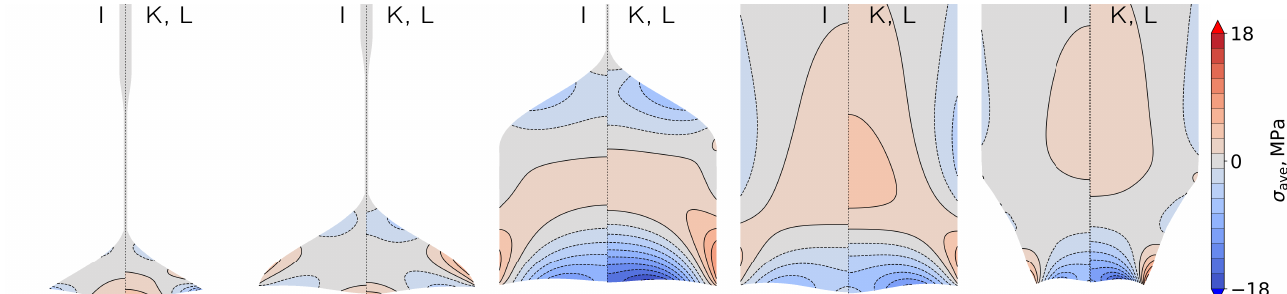
Figure 4. Mean thermal stress σ ave (negative–compressive stresses shown with dashed isolines) for parameter sets I ( left side), K and L ( right side). In reading order: cone ( L = − 50mm); shouldering (0mm); body phase (200mm); body phase (1000mm); endcone